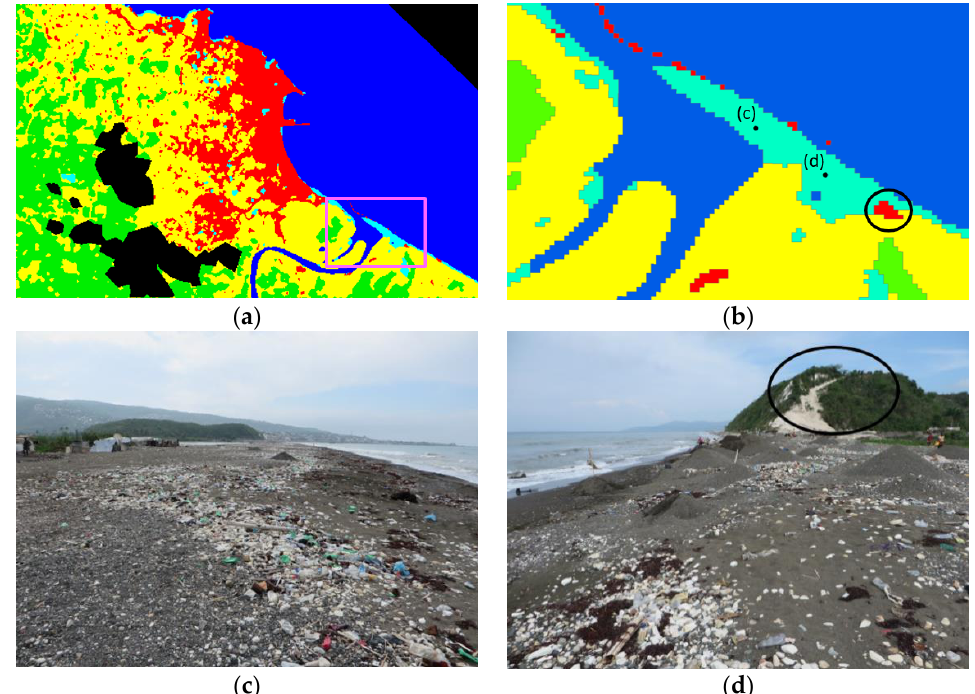
Figure 13. ( a ) The 2019 classification map (see Figure 8 and related legend) with indication of ( b ) the bare-soil land cover transition at the mouth of the Grande Anse River and along the coast, south of Jérémie. Black dots mark the GPS locations of the ground-truth photographs showing ( c ) the sand and gravel river mouth bar interspersed with widespread rubbish and waste and ( d ) mining and quarrying activity occurring on-site in April 2019.